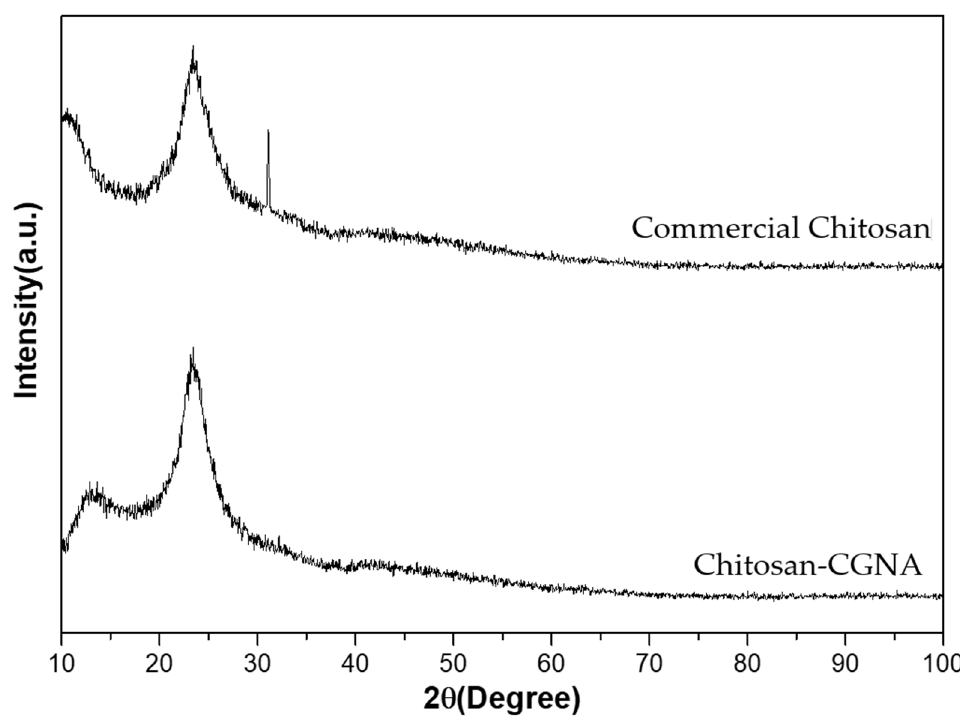
Figure 5. XRD pattern of Chitosan-CGNA and commercial chitosan.